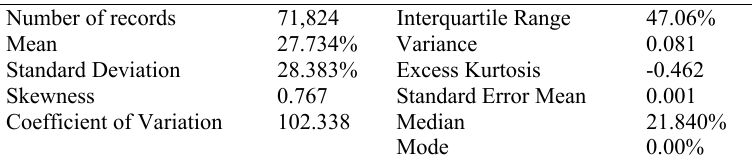
Table 3 : Descriptive Statistics for Dividend Payout